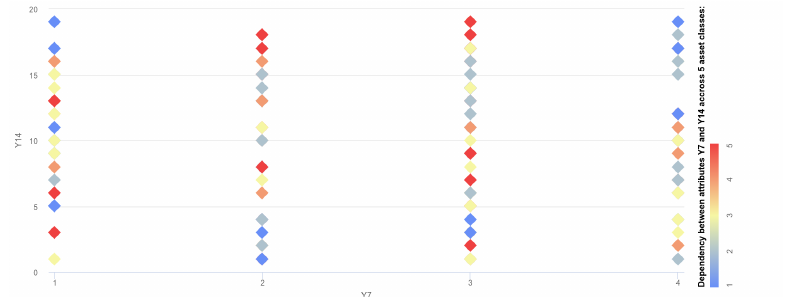
Figure 6. Correlation between attributes in dataset.